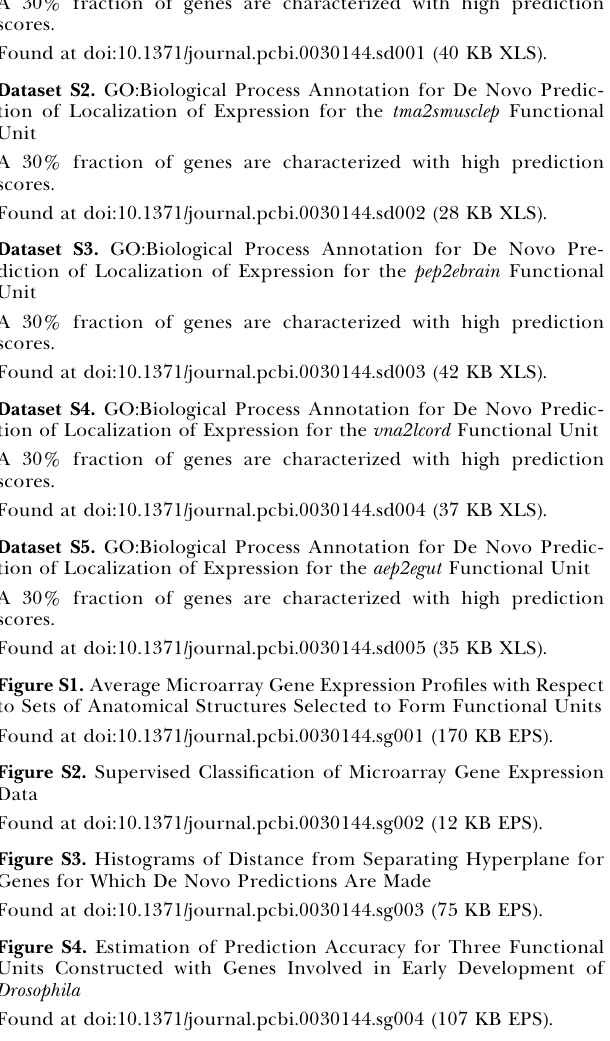
Figure S5. Estimation of Prediction Accuracy for Three Functional Units Constructed with Genes Involved in Mesoderm Development in Figure S6. Estimation of Prediction Accuracy for Three Functional Units Constructed with Genes Involved in Intestinal Tract Develop- Figure S7. Estimation of Prediction Accuracy for Three Functional Units Constructed with Genes Involved in Brain Development in Figure S8. Estimation of Prediction Accuracy for Three Functional Units Constructed with Genes Involved in CNS Development in